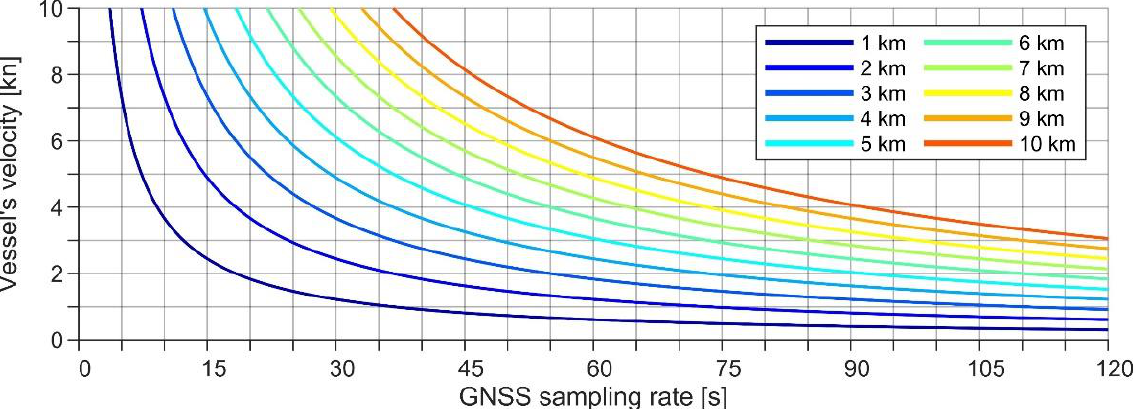
Figure 10. Filtering window length dependency on GNSS sampling rate and vessel velocity, by assuming an optimal filtering window size of 53 measurements.